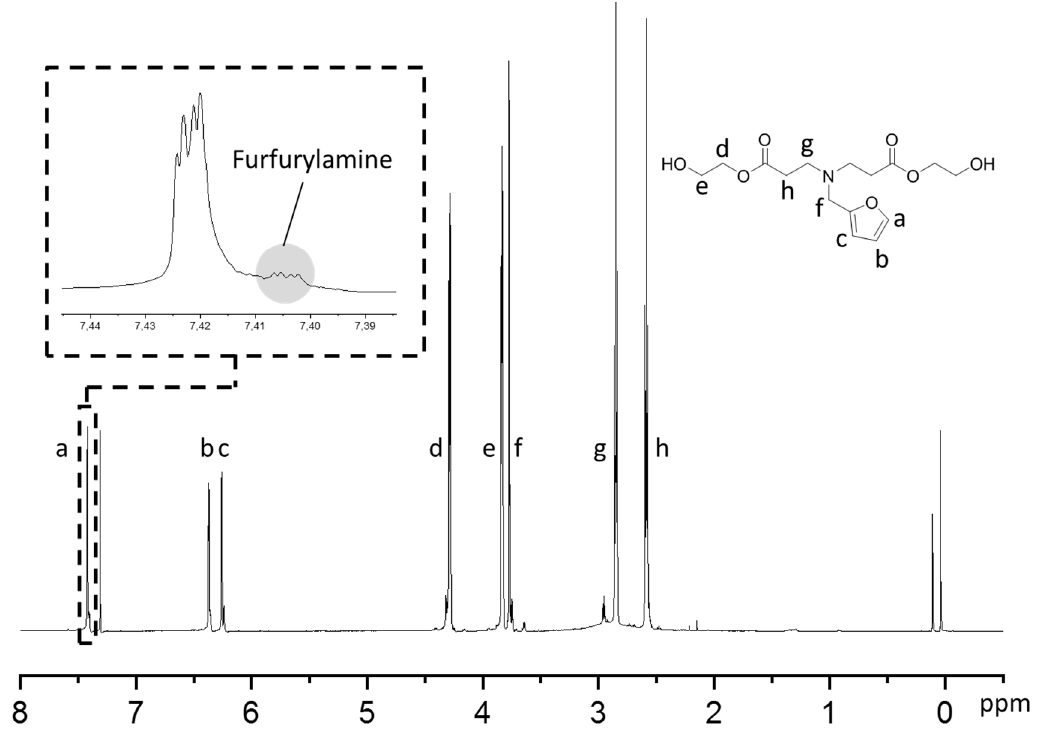
Figure 1. 1 H-NMR MicAdd B; product containing traces of furfurylamine.